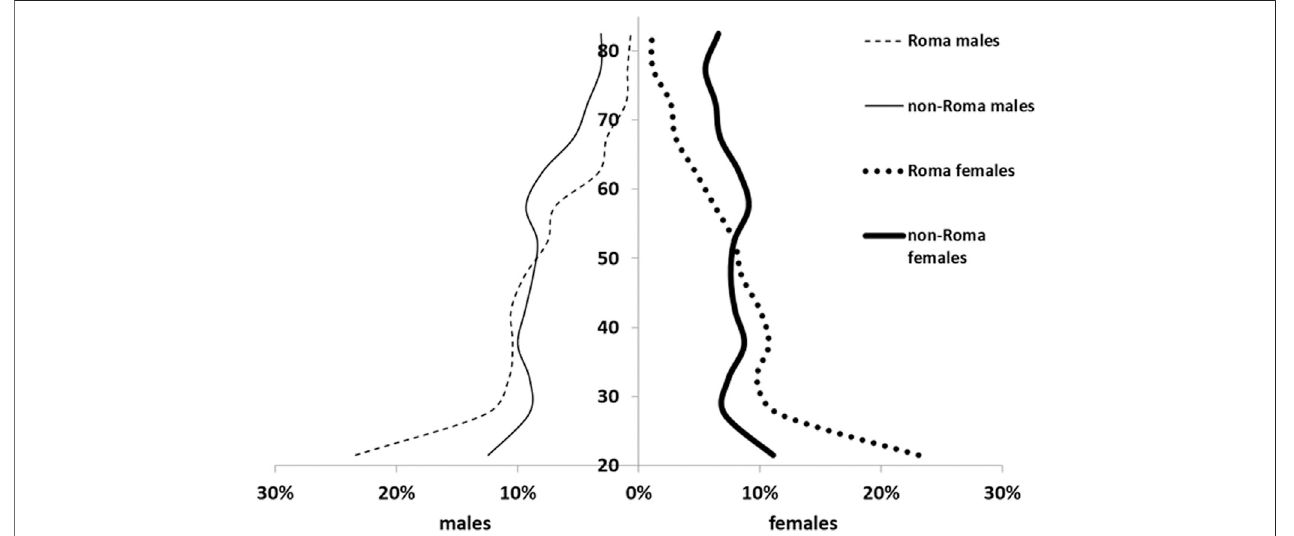
FIGURE 1 | Demographic structures of investigated populations living in segregated Roma colonies (SRC) and complementary areas (CA).